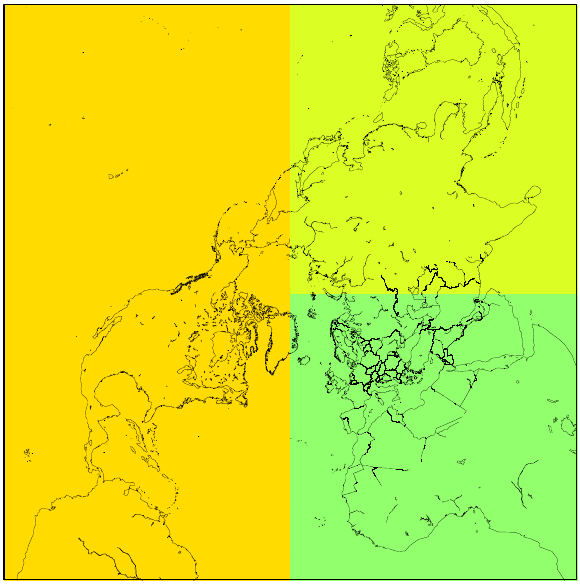
Figure 1. The DEHM model domain, including the sub-division into the major source areas North America (orange), Europe (dark green) and Asia (light green), applied in Section